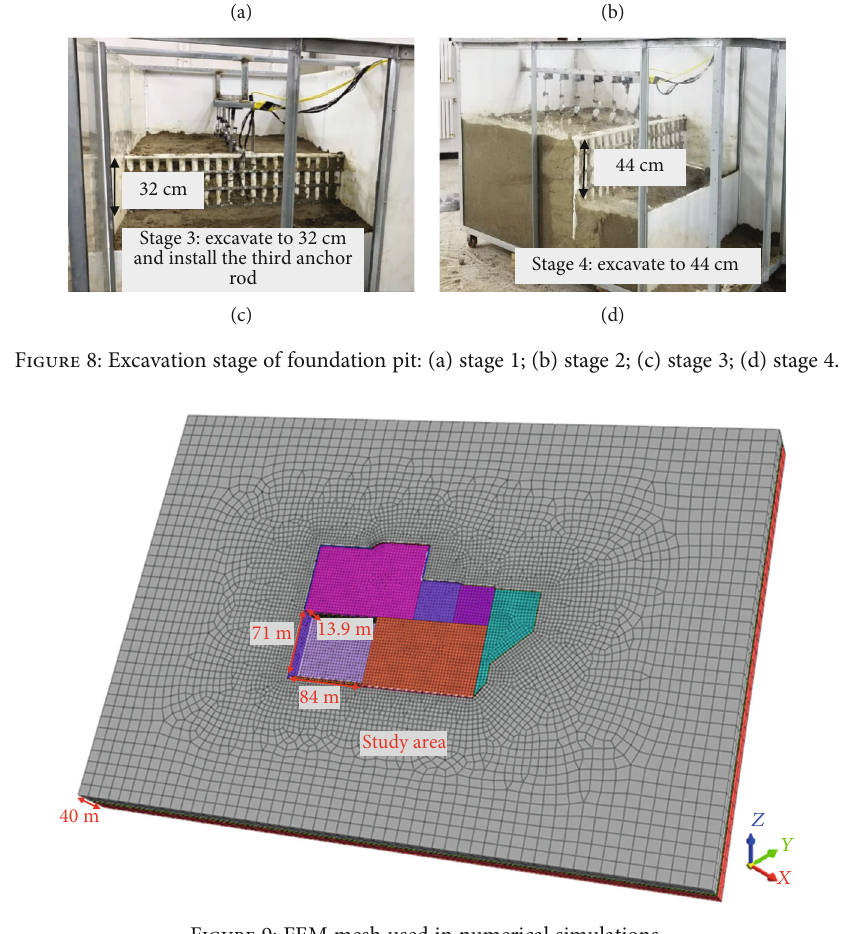
Figure 9: FEM mesh used in numerical simulations. Table 4: Geotechnical parameters used in the